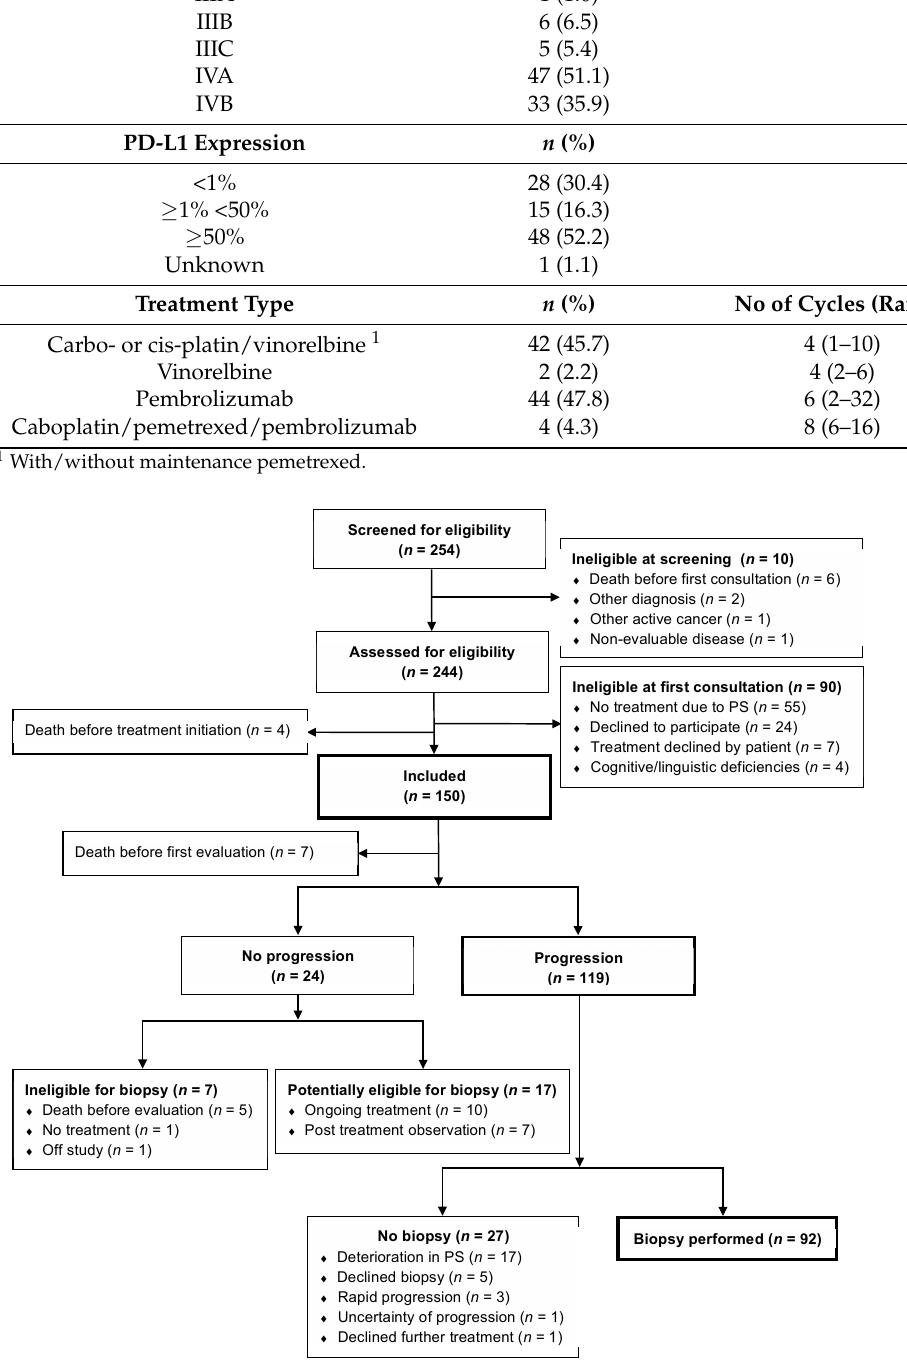
Figure 1. Consort Figure 1. Consort diagram. Table 1. Baseline characteristics of re-biopsied patients. Baseline Characteristics of Re-Biopsied Patients ( n = 92)